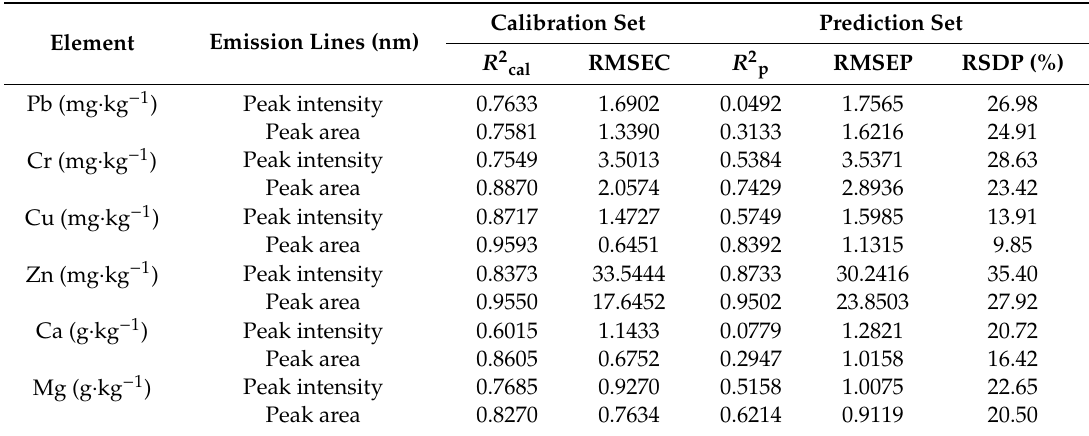
Table 3. Model results of univariate calibration curve method.